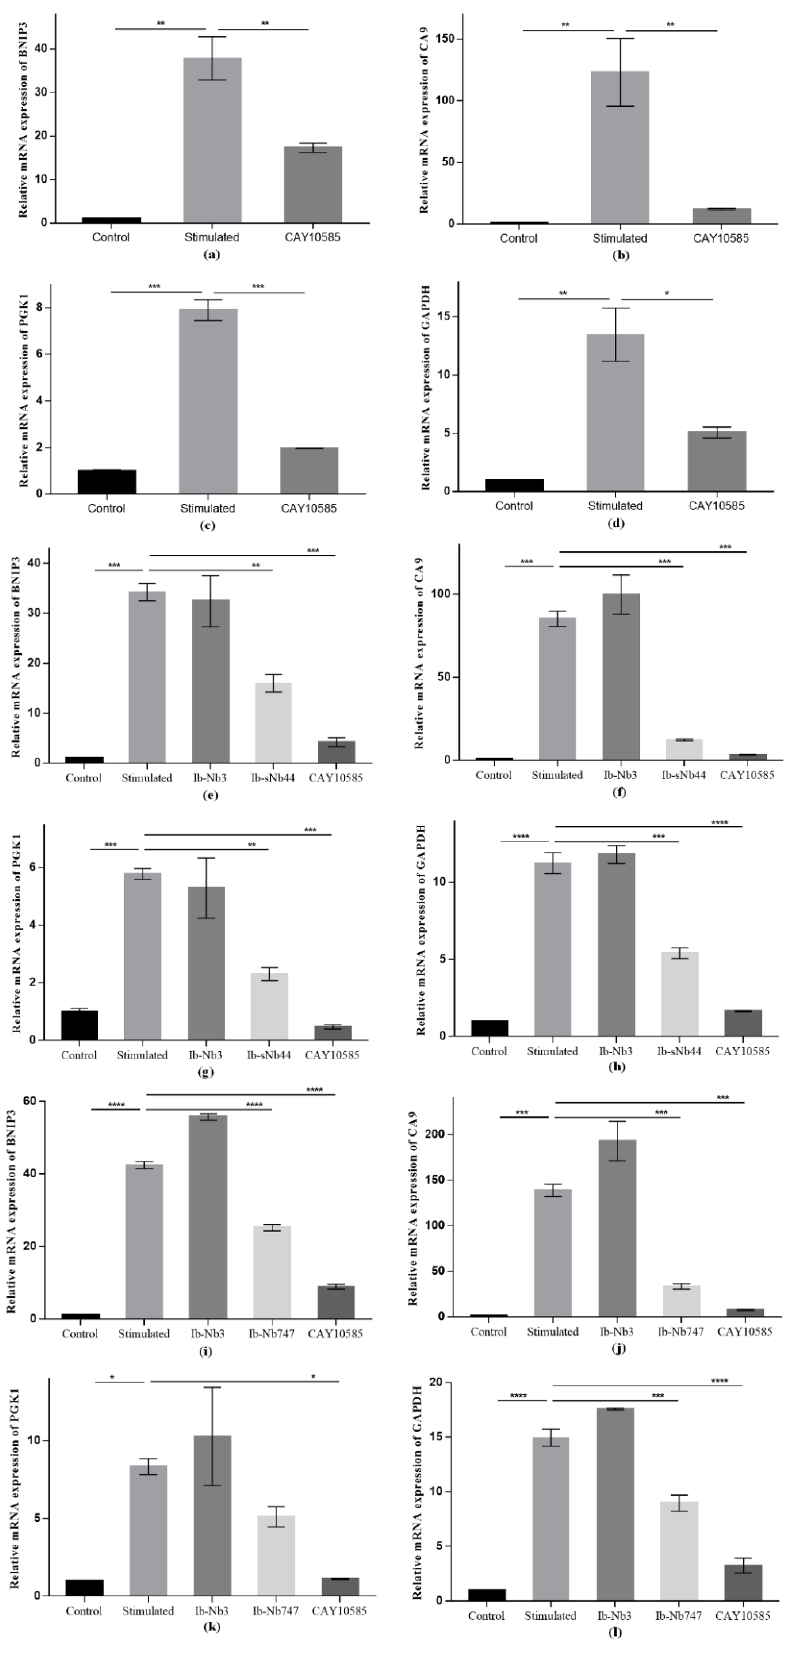
Figure 6. Expression level of HIF-1 related target genes. HeLa cells were stimulated with 0.3 mM CoCl 2 for stabilization of endogenous HIF-1 α protein. HIF-1 related target genes of BCL2